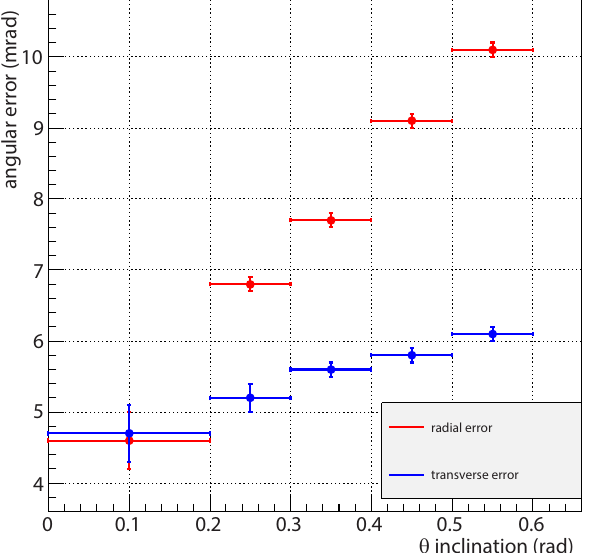
Fig. 5. Angular resolutions in the radial (red) and transverse (blue) coordinates. The horizontal axis represents the angle between a track and the normal direction of the detection plane (inclination: θ ).